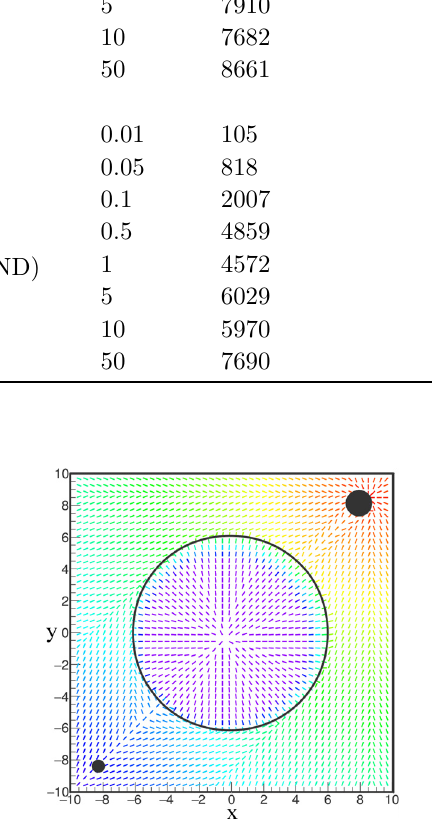
Fig. 2. INIPOND importance map for the bypass